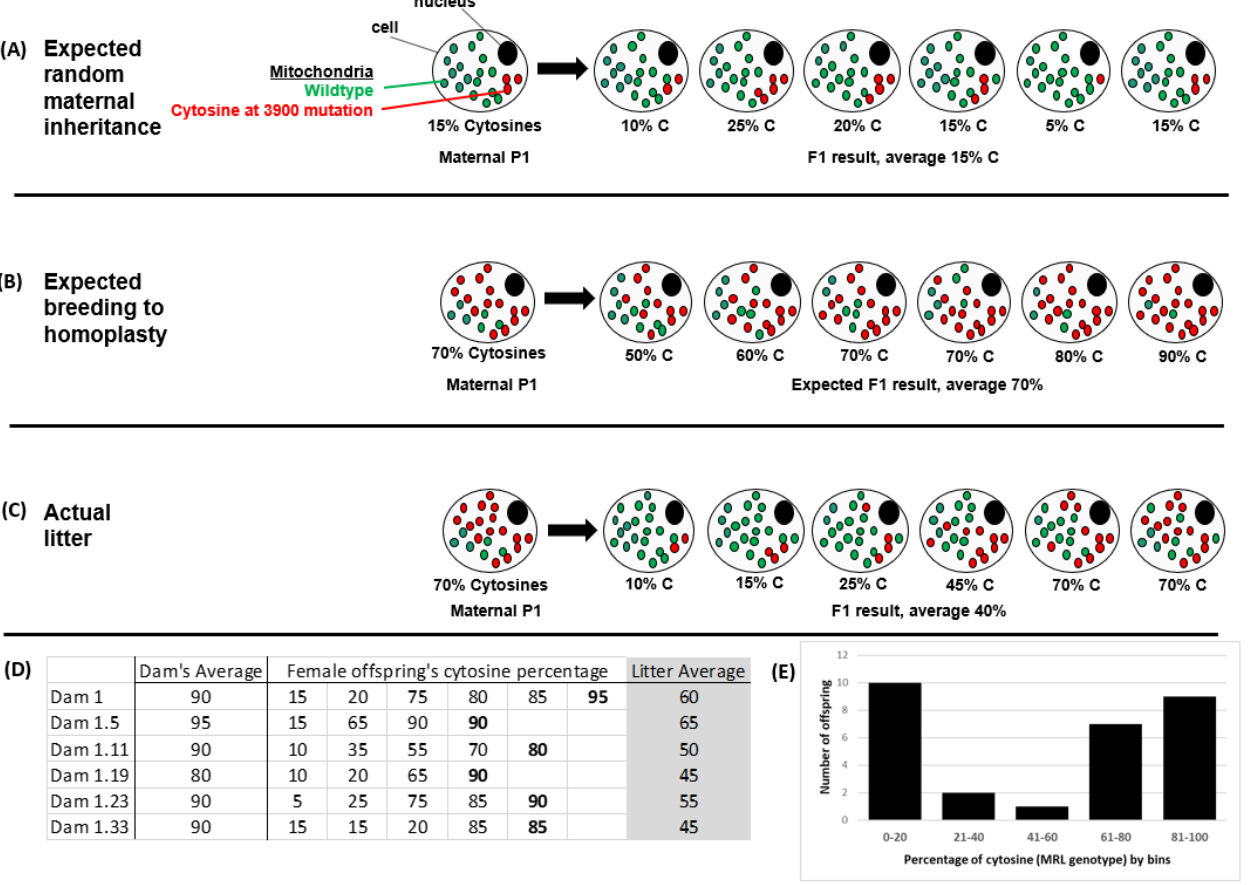
Figure 1. Introduction to heteroplasmies. The nature of mitochondrial segregation during oogenesis is not random in the MRL mouse strain. ( A ) The expected random segregation is illustrated, where the offspring’s percentage of mutant mitochondria would center around the dam’s percentage. ( B ) Using this randomness, we should be able to generate mitochondrial homoplasmy; i.e., mitochondrially pure breeding mouse lines. ( C ) Instead, we noted that mitochondrial genome appeared to be reset during each generation centering on ~40% mutant cytosines at the 3900 position. An actual litter is depicted. ( D ) Our breeding scheme to achieve a pure MRL mitochondrial line of mice. In each case the female offspring with the highest percentage cytosines was chosen to be the Dam (bolded) for the next generation. We, however, never got to 100% MRL and the subsequent litters consistently reset to lower values, (as seen in the average column, shaded grey). ( E ) Graphical representation of the Dam 1 offspring data, illustrating the often-noted bell-shaped nature of this mito- chondrial reset.